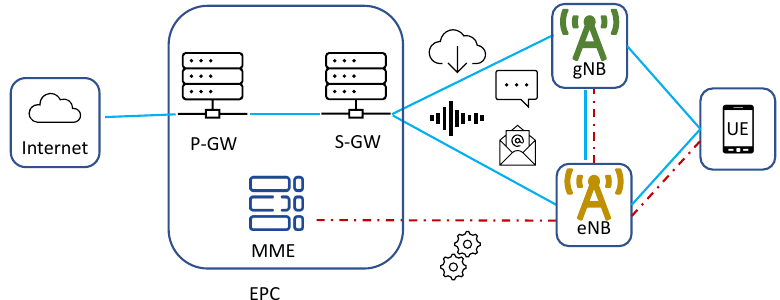
Figure 2. Core and Radio Access Network (RAN) configurations as per 5G NR NSA Option 3x.